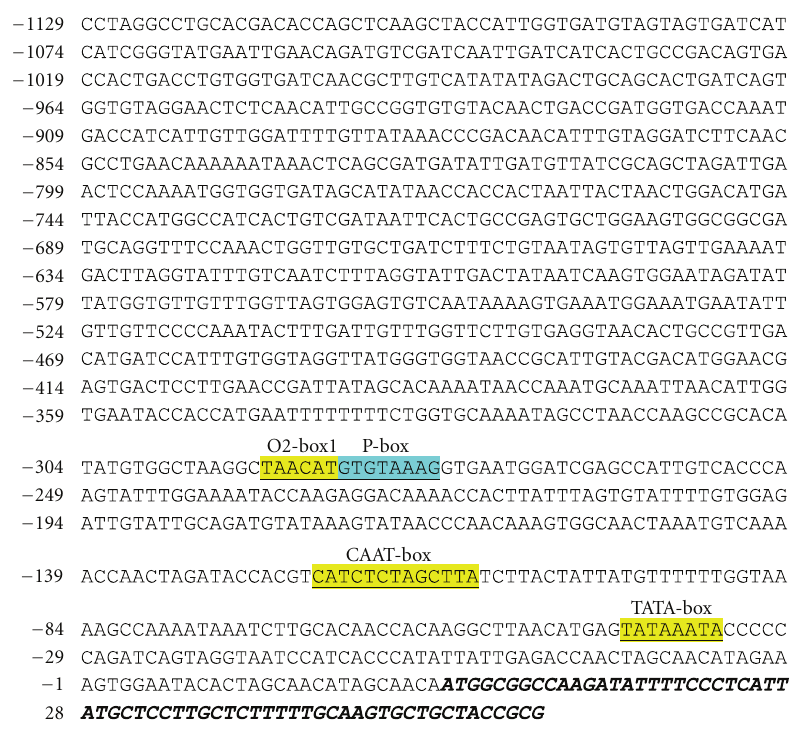
Figure 1: Full sequence of the isolated putative α -kaf promoter and ss . The elements found in the promoter region sequences are underlined and the respective names indicated. The putative ss is highlighted in italics.